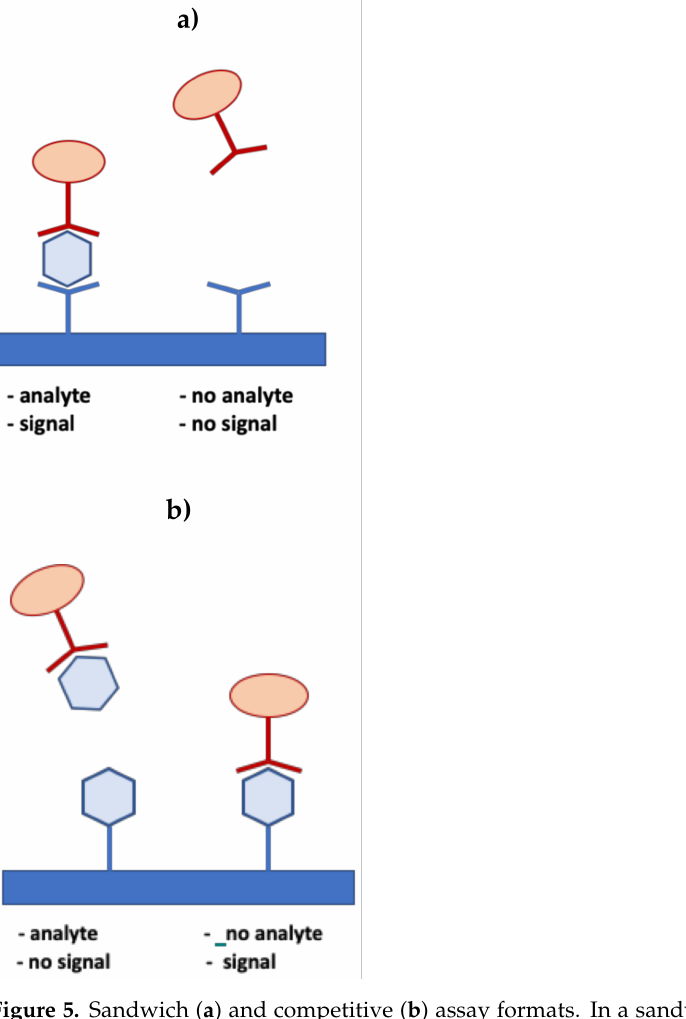
Figure 5. Sandwich ( a ) and competitive ( b ) assay formats. In a sandwich assay, a positive signal indicates the presence of the analyte, while in a competitive format, the signal on the test line means no analyte is